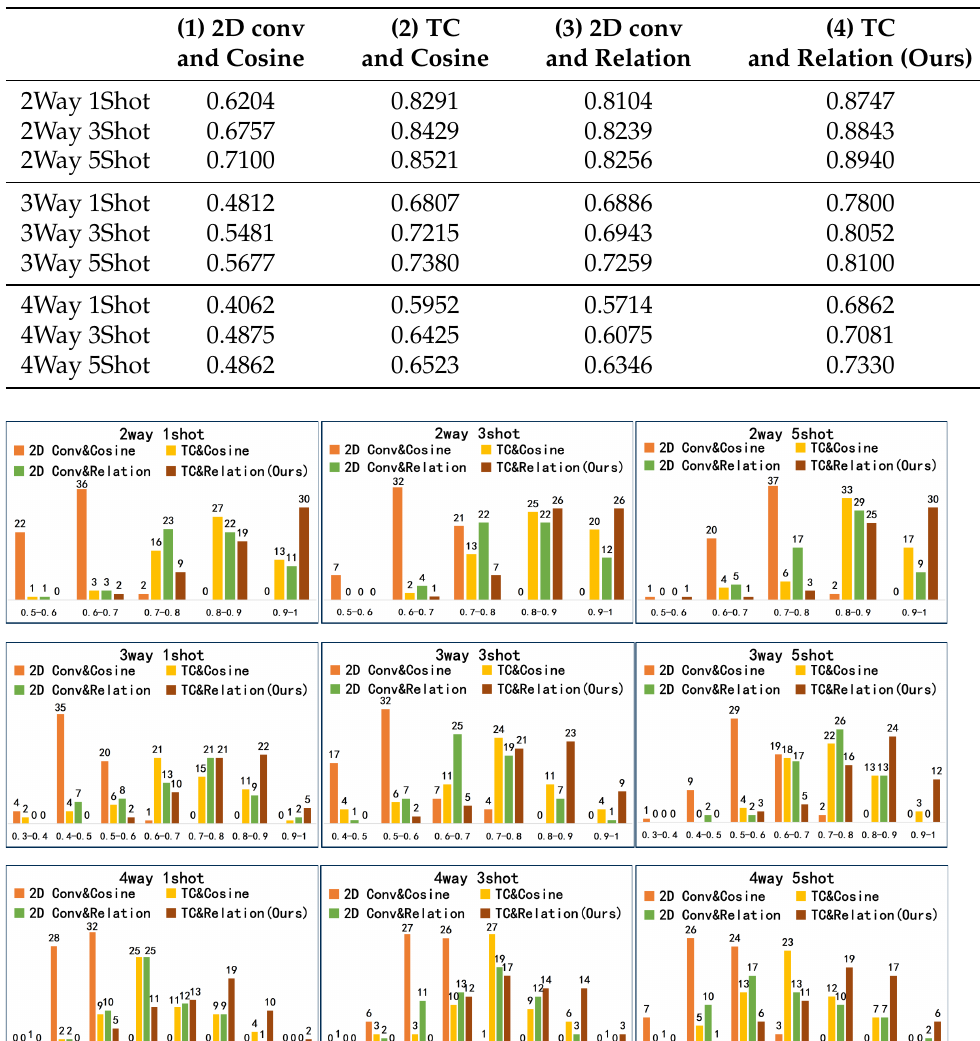
Table 1. The results of the methods using different embedding and metric modules (The 2D conv is the 2D convolutional module and the TC is the TriangleConv module).